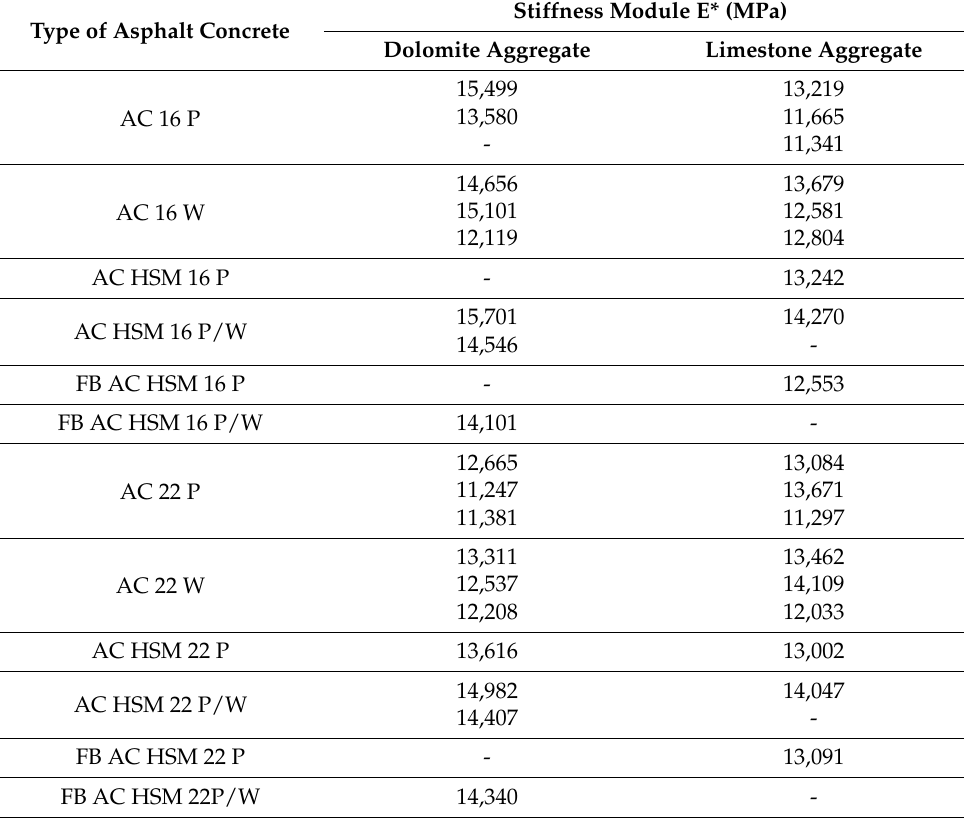
Table 4. Stiffness module depending on the type of asphalt concrete (AC). Explanation of symbols used for mixtures: AC—asphalt concrete; AC HSM—asphalt concrete with high stiffness; FB AC HSM—asphalt concrete with high stiffness with application of foam bitumen; P—foundation layer mixture; W—binding layer mixture; P/W—foundation or binding layer mixture; 16 and 22—upper limit of aggregate in millimeters, lower limit is 0 mm.